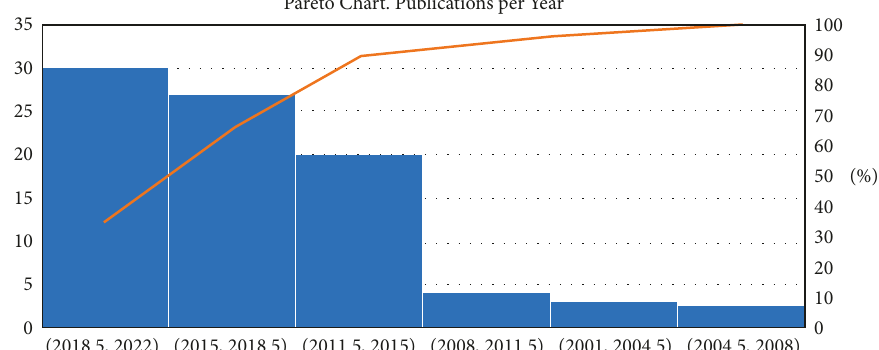
Figure 1: Number of related publications reviewed in this work (99 selections) per year since 2000.